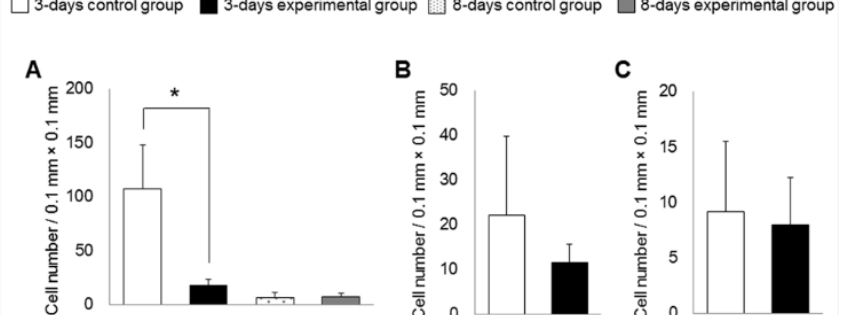
Figure 4. Numbers of polymorphonuclear leukocytes in alveolar sockets. In the upper region ( A ), but not the middle ( B ) and the bottom ( C ) regions, the number of polymorphonuclear leukocytes was lower in the experimental group than in the control group at 3 days. In the upper regions, there were no significant differences in number of polymorphonuclear leukocytes between the groups at 8 days. Bars represent means ± SD of 5–6 rats. * p < 0.05 compared with control